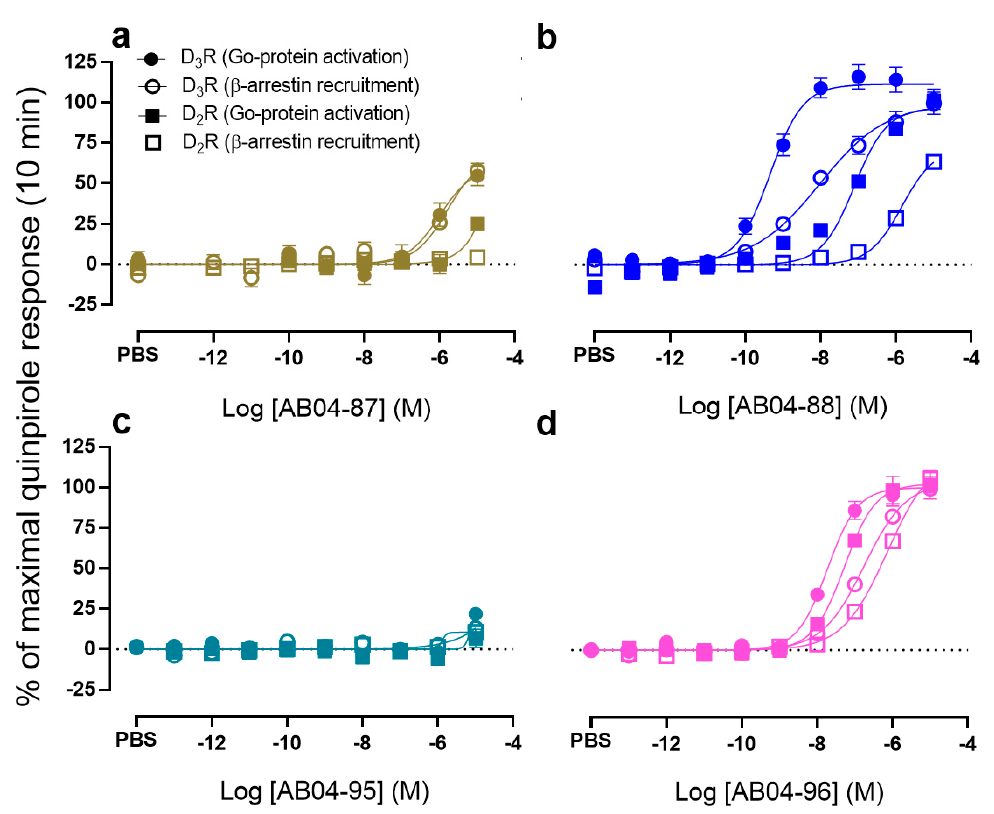
Figure 3. Pharmacological comparison of cis and trans pairs in both D 3 R and D 2 R mediated G protein activation and β -arrestin recruitment at 10 min. CRCs of AB04-87 ( a ), AB04-88 ( b ), AB04-95 ( c ) and AB04-96 ( d )-induced BRET at 10 min between G α o-RLuc and G γ -Venus and D 3 R or D 2 R-Rluc and β -arrestin2-Venus. CRCs are plotted as percentage of maximal response by quinpirole and presented as means ± SEM of n ≥ 3 independent experiments.